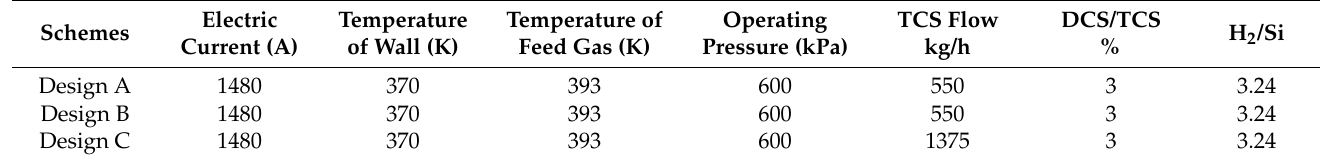
Table 2. Process parameters.